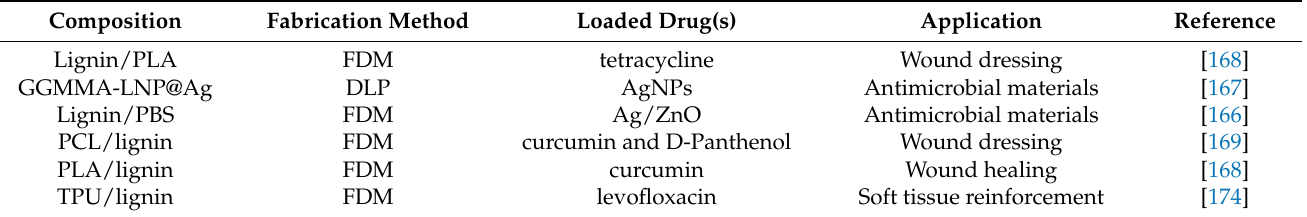
Table 4. Lignin-based 3D printed scaffolds applied for delivery of various bioactive